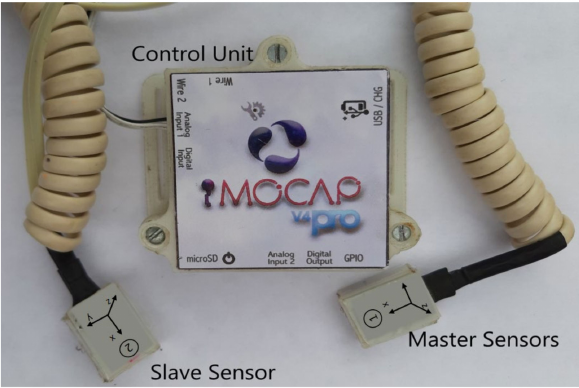
Figure 2. Imocap-GIS system.